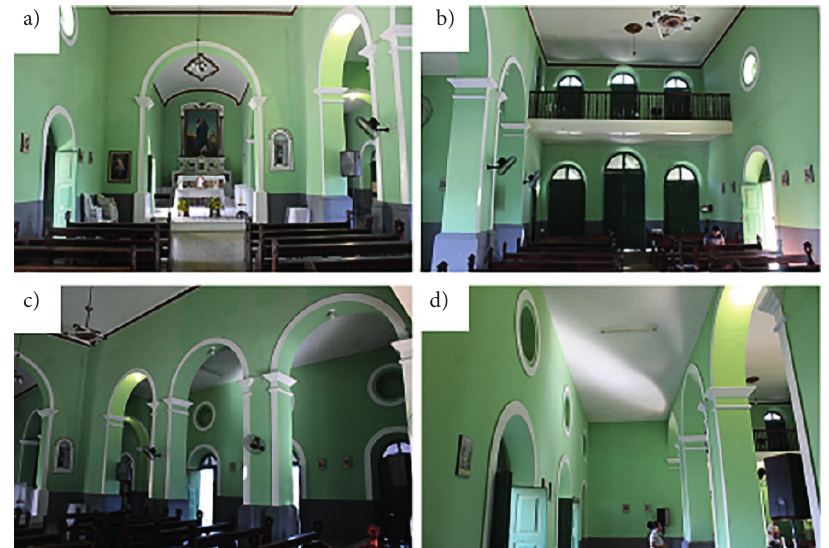
Fig. 4. Interior of the Nossa Senhora do Rosário Church: a) Altar-Mor; b) Central Nave and Coro Alto; c) columns and arches and d) lateral